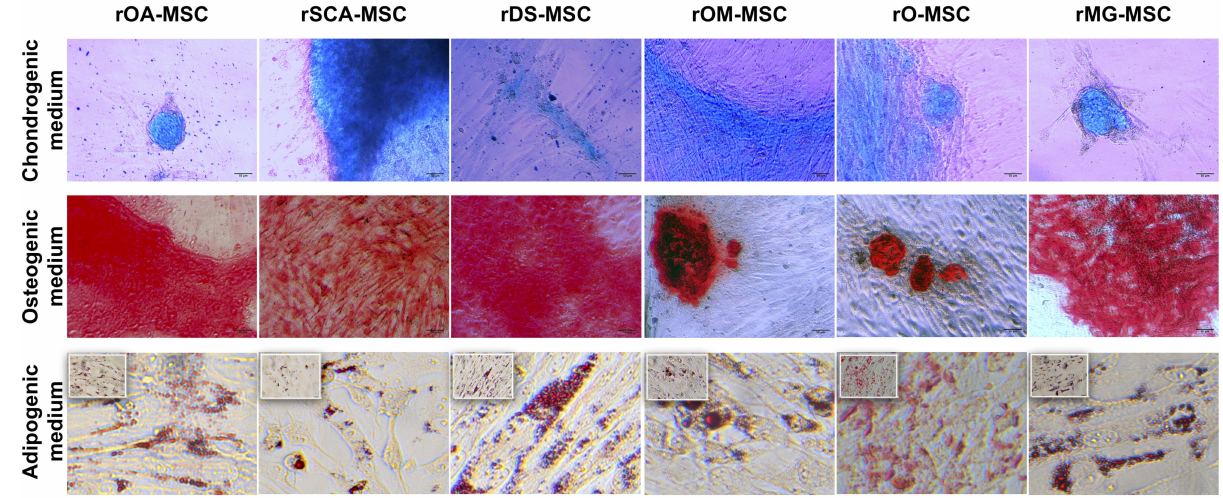
Figure 4. In vitro differentiation of rMSC to different lineages. Images show Alcian blue staining of acidic proteoglycan in cells cultured in chondrogenic differentiation medium ( top panel); Alizarin Red S staining of calcium deposits in cells cultured in osteogenic differentiation medium ( middle panels); and Oil red O staining of lipid droplets in cells cultured in adipogenic differentiation medium ( bottom panels). Bright-field images were acquired with 200 × magnification (bars = 50 µ m) for top and middle panels and with 400 × magnification (bars = 100 µ m) for bottom